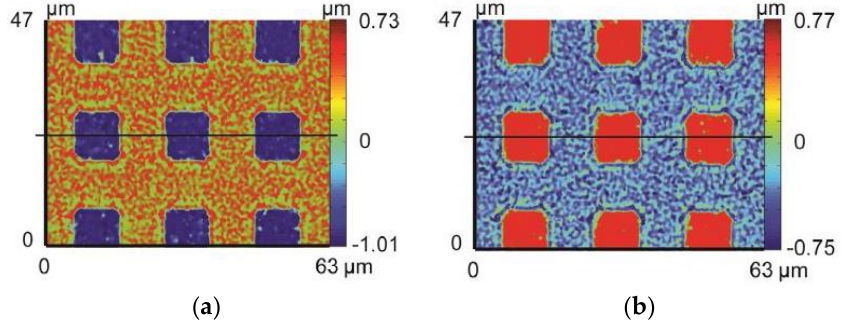
Figure 31. Microscope images of microstructures on ( a ) mold surface and ( b ) molded ChG surface after localized rapid heating process [65].